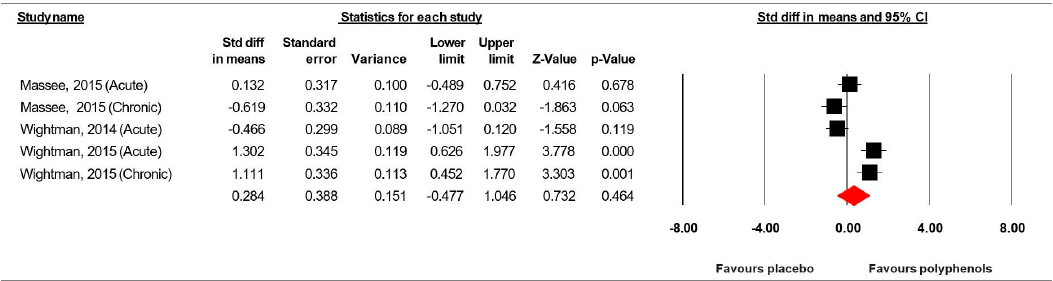
Figure 4. Forest plot of studies investigating the effect of (poly) phenols-rich supplementation on rapid visual information processing (% correct) (RVIP).